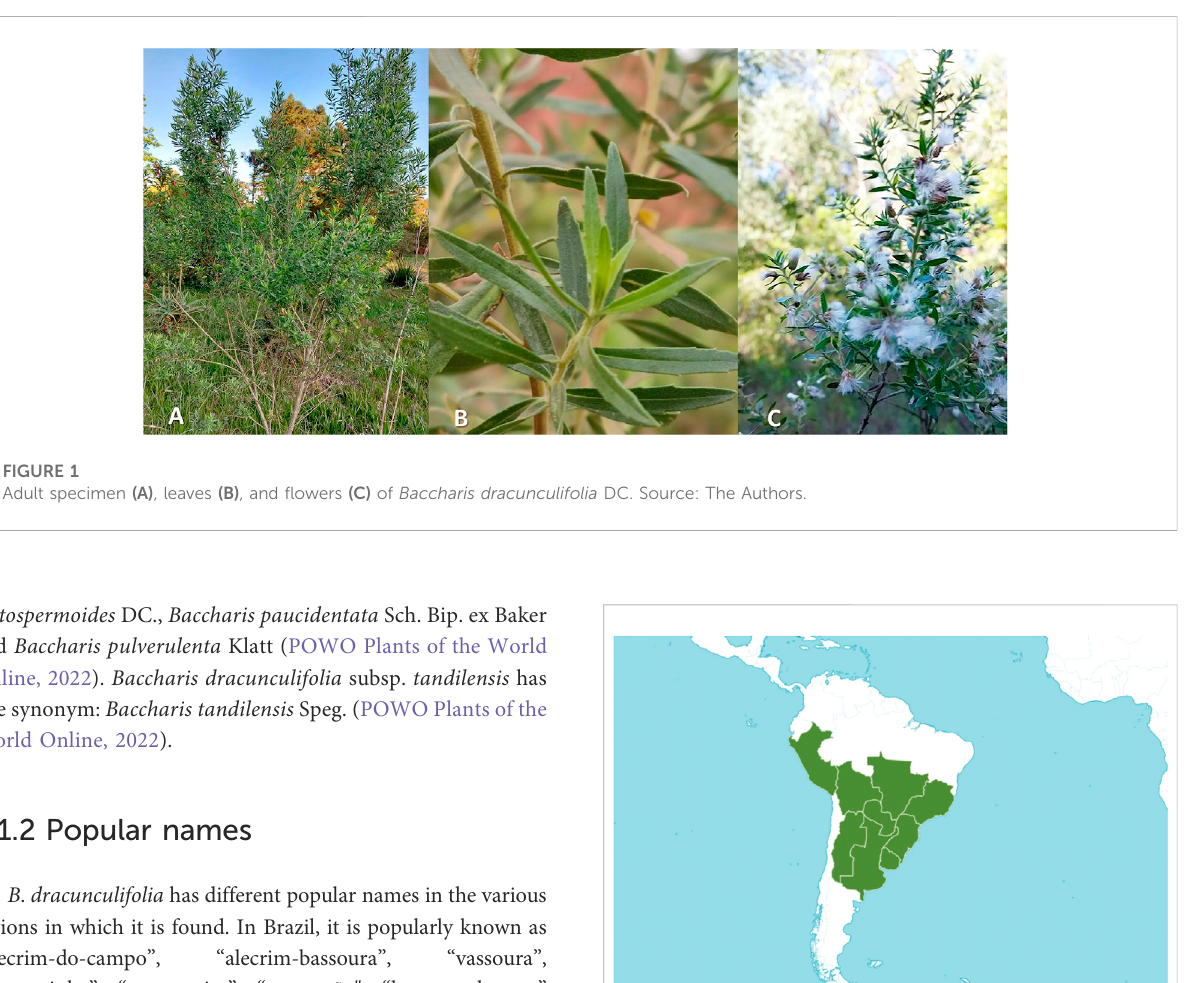
FIGURE 2 Geographical distribution of Baccharis